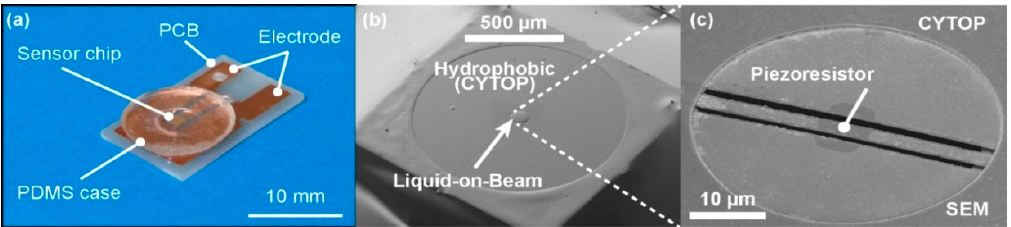
Figure 2. ( a ) SA sensor appearance, ( b ) SEM (scanning electron microscope) image of sensor chip and ( c ) SEM image of n-type doped piezoresistive area.